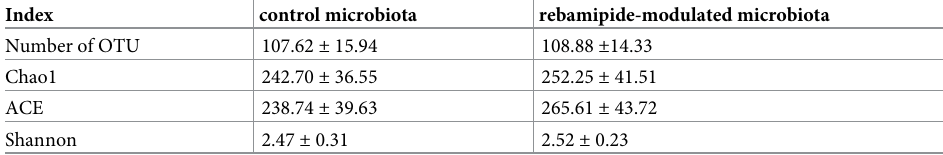
Table 1. α -diversity, measured by operational taxonomic unit (OTU) number, Chao1 index, ACE index, and Shannon’s diversity index of small intestinal lumen contents in mice given rebamipide or